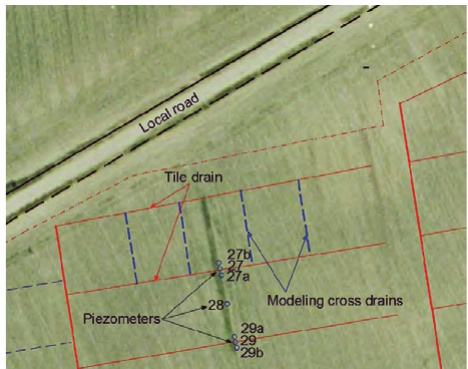
Fig. 2. The experimental site (at Pikeliai, a village in the Kėdainiai district)